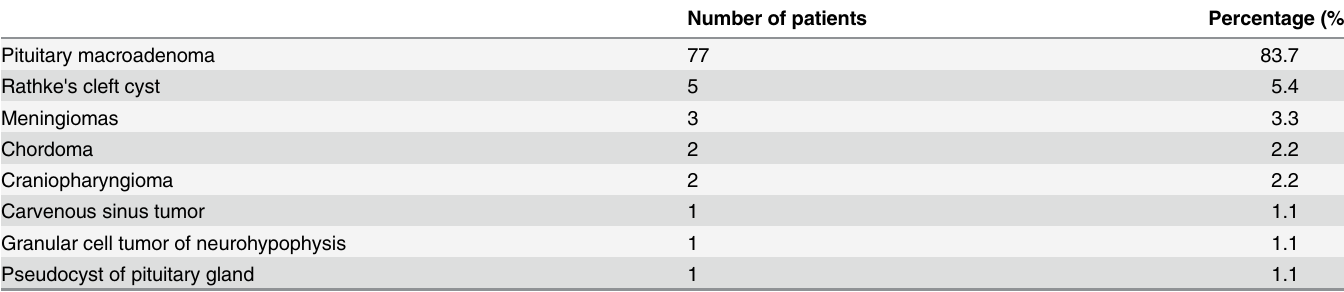
Table 1. Types of tumors resected via EETSA.